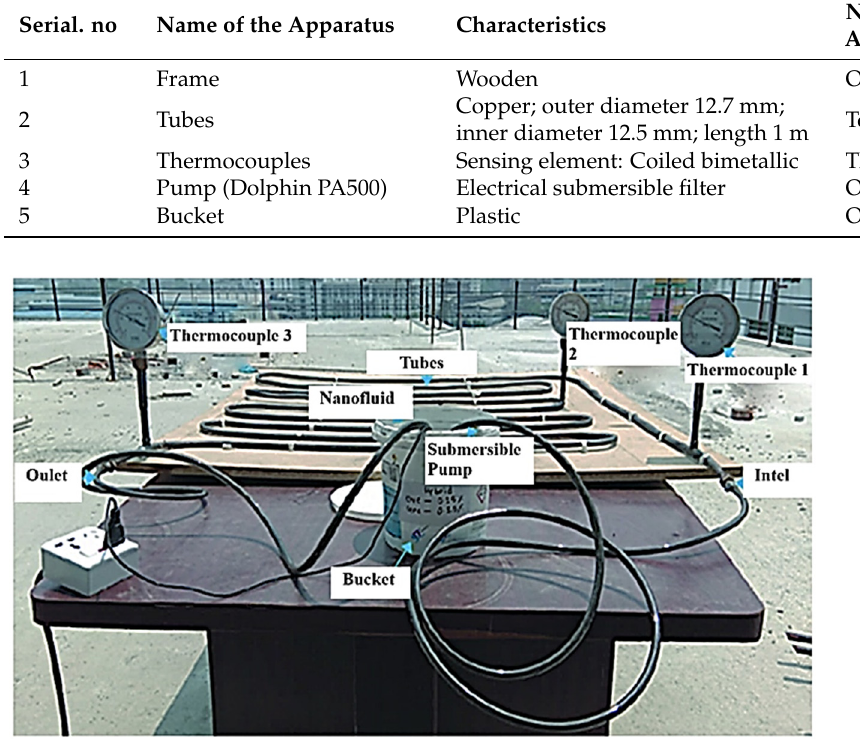
Table 1. Description of the experiment.